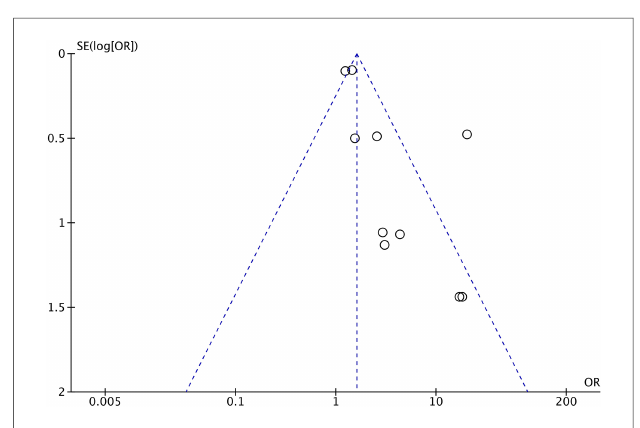
FIGURE 5 Funnel plot for observational cohort studies comparing EAB and PEAB. Odds ratios were calculated using RevMan. EAB, empirical antibiotics use; PEAB, prolonged EAB; NEC, necrotizing enterocolitis; SE, standard error; OR, odds